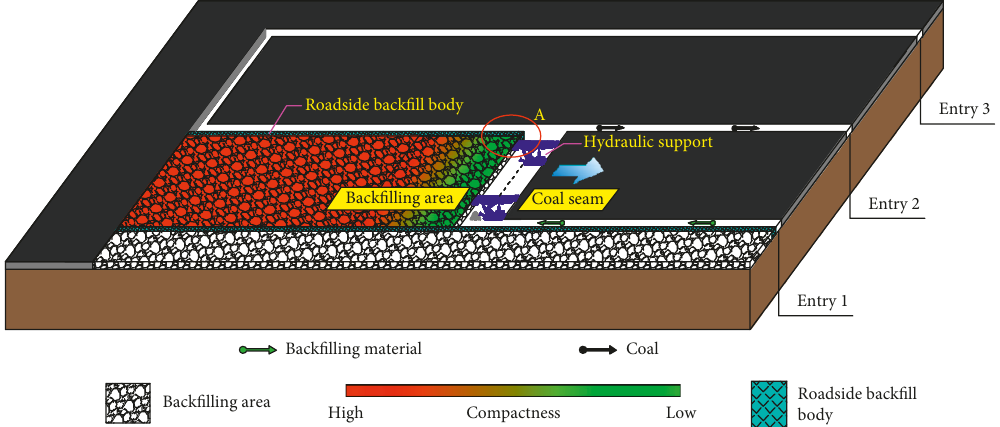
Figure 9: Schematic diagram of the vertical stress distribution in the backfilling area.